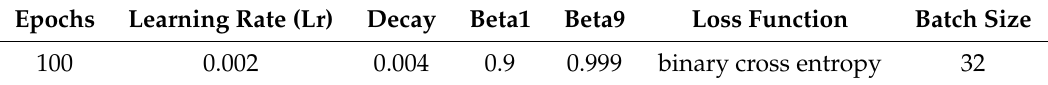
Table 4. Training parameters for binary classification with the Nadam optimizer.